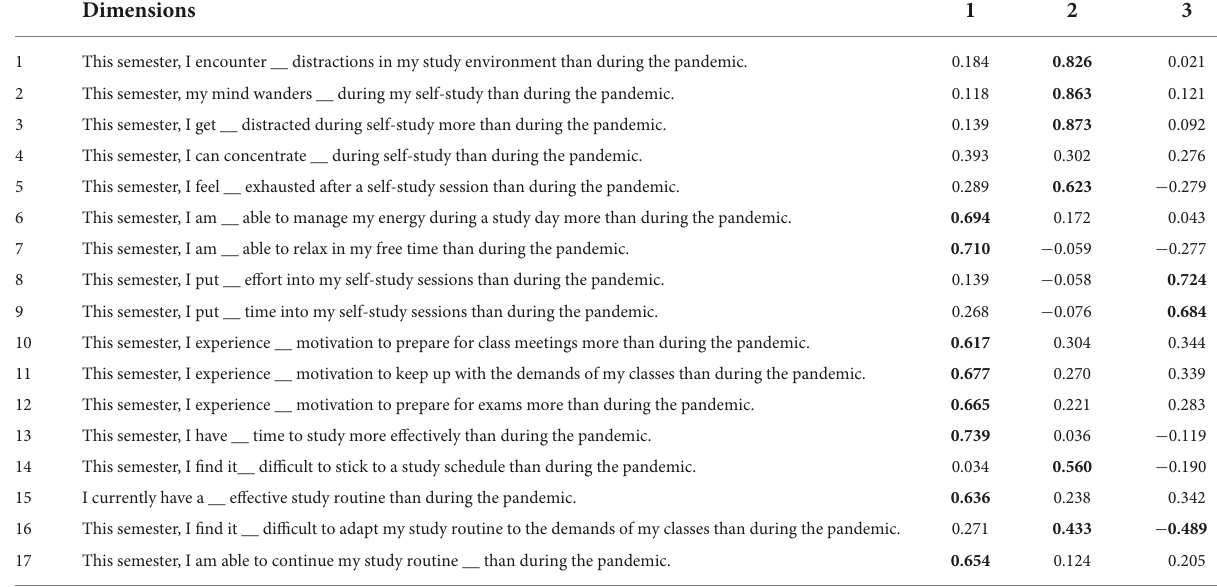
TABLE 2 Dimensions of students’ responses to change. Dimensions